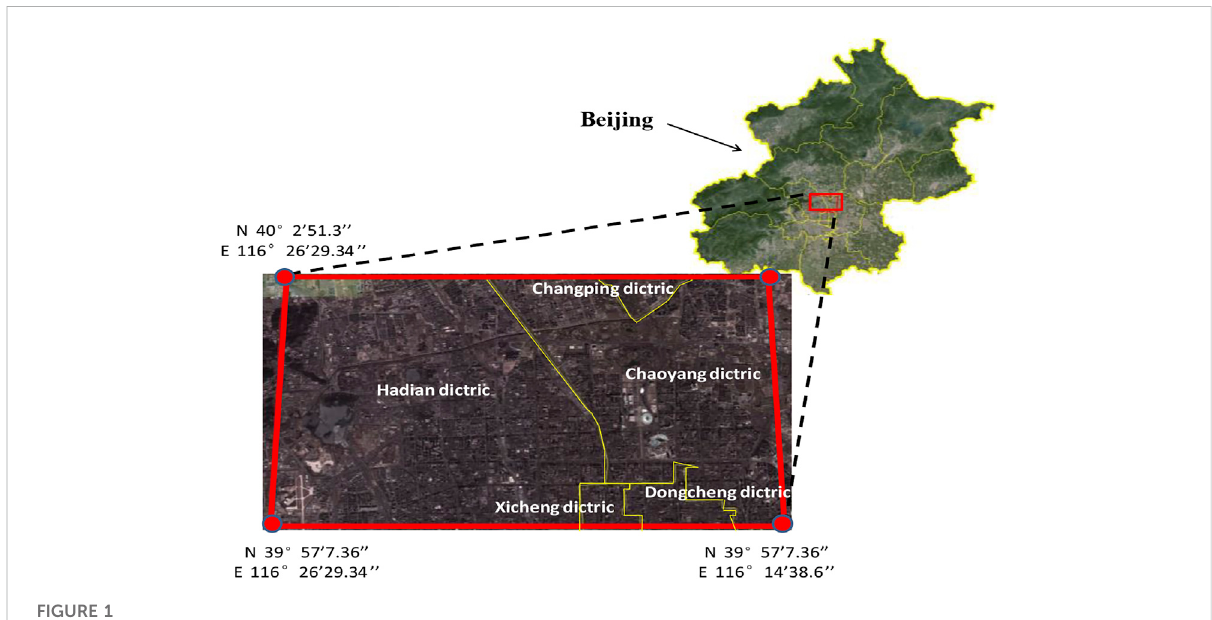
FIGURE 1 Study area (bold-red bordered